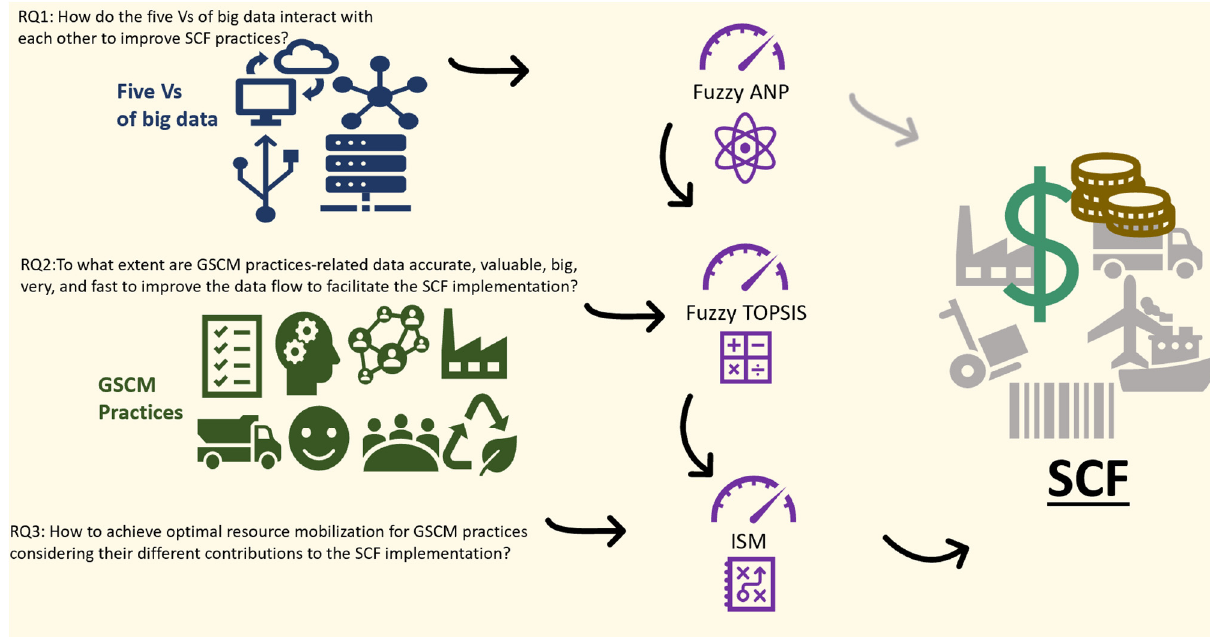
Figure 1. The perception of the proposed hybrid self-assessment model .